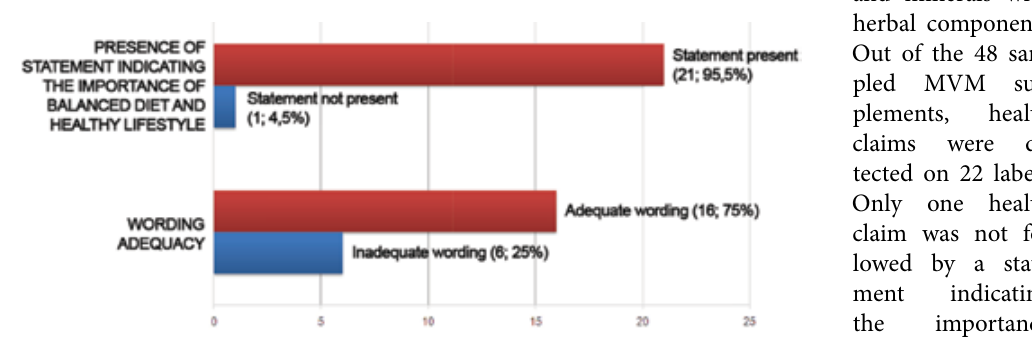
FIGURE 3. Compliance of health claims with national